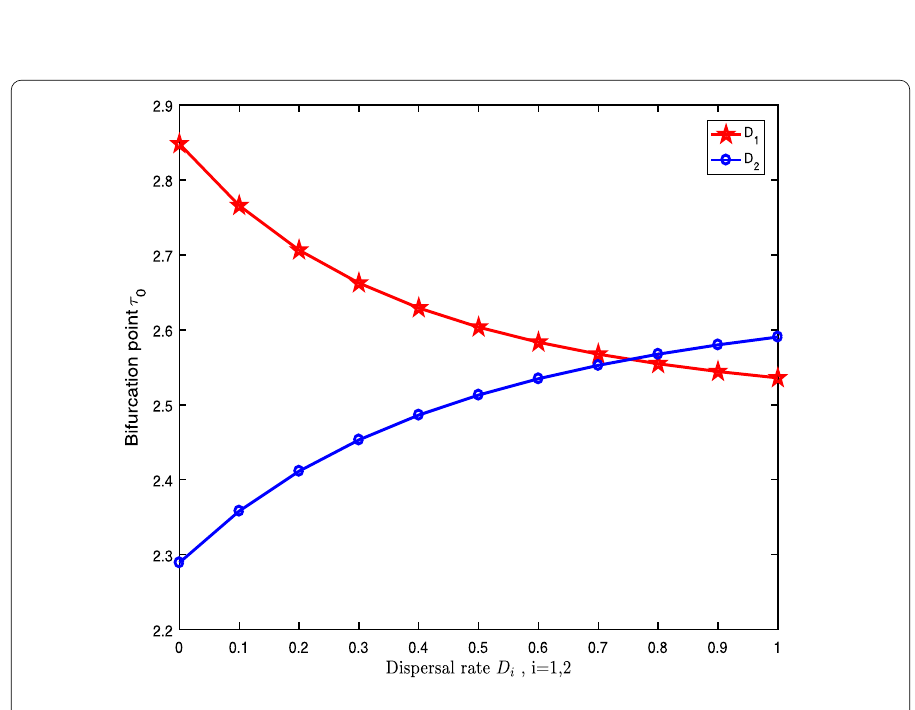
Figure 3 The impact of dispersal rate D 1 or D 2 on τ